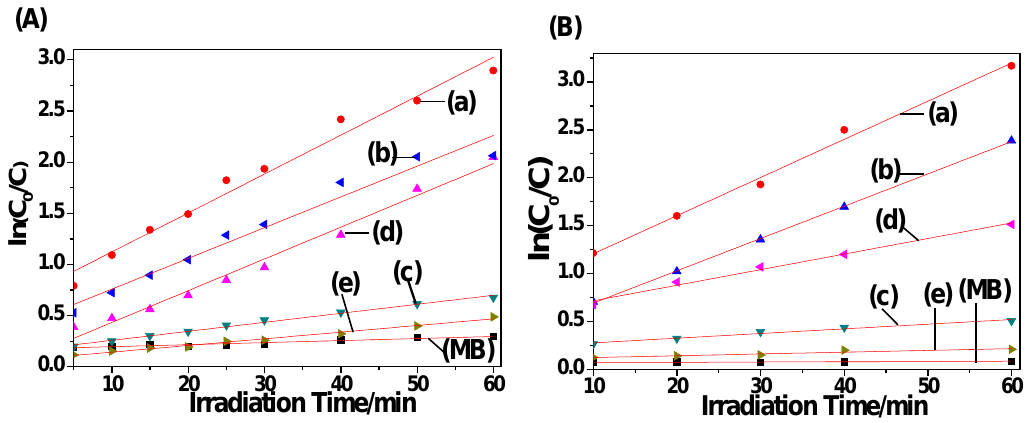
Figure 11. Linear transform ln(C 0 /C) = f(t) of the kinetic curves of MB ( A ) under UV irradiation and ( B ) under visible light irradiation: (a) C-S1, (b) C-S2, (c) C-S3, (d) C-S4, and (e) C-S0.